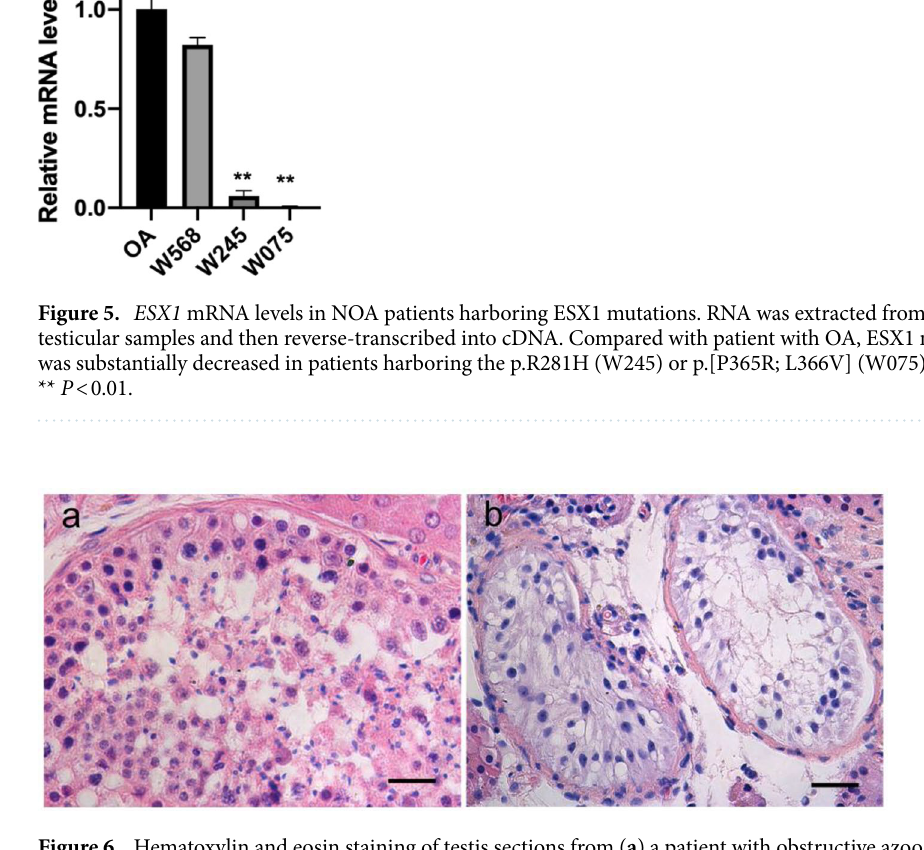
are expected to reflect both the pituitary and testicular function in physiological and pathological conditions 25 .